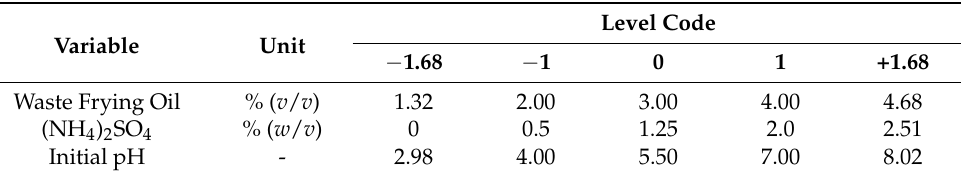
Table 3. Maximum and minimum levels of variables used for optimizing the production of CBLs and CBM with O&G removal in RSM-CCD.